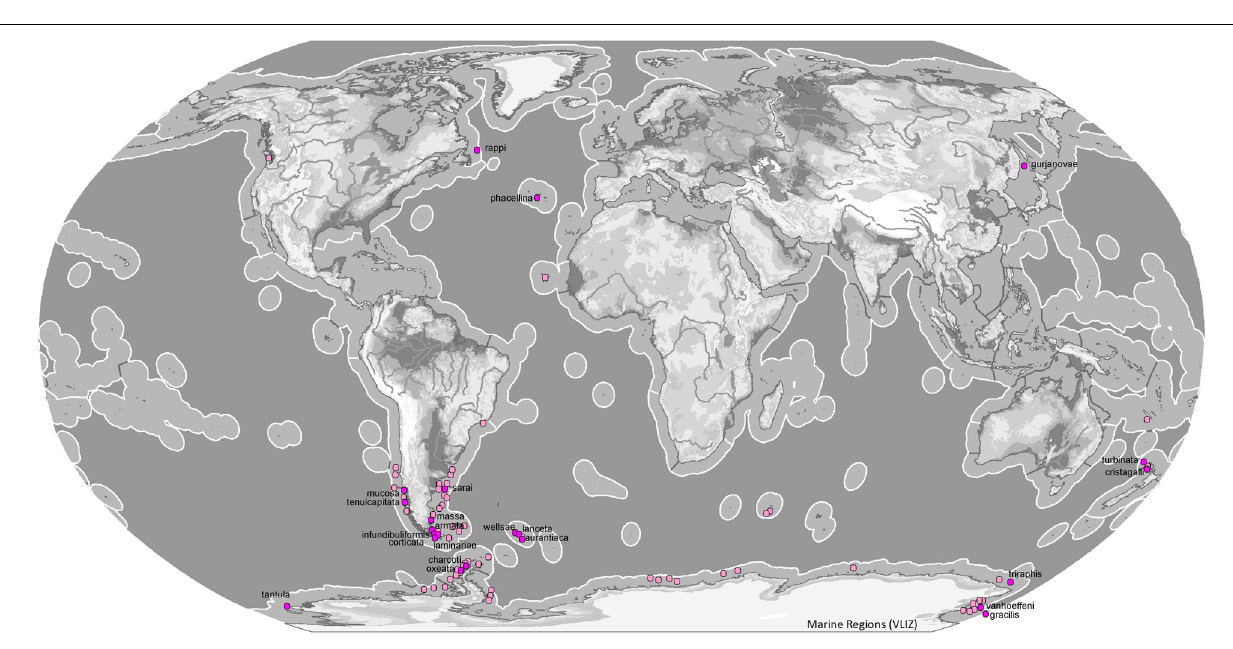
Frontiers in Marine Science |